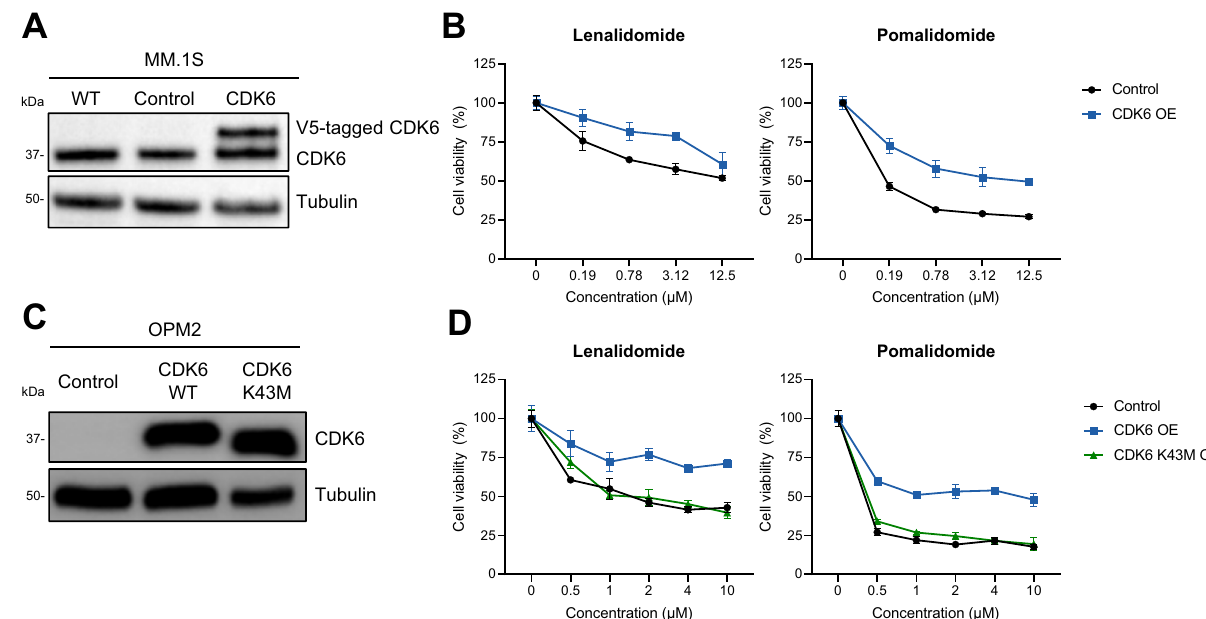
Fig. 2 High expression levels of CDK6 confers augmented IMiD-resistance. A Overexpression of CDK6 in MM.1S cells using lentiviral transduction con fi rmed through western blot analysis. B Cell viability of CDK6-overexpressing MM.1S cells upon 96 h treatment with lenalidomide and pomalidomide at indicated concentrations. ( N = 3 biologically independent replicates). C Overexpression of CDK6 in OPM2 cells using retroviral transduction con fi rmed through western blot analysis. D Cell viability of CDK6 WT or K43M-overexpressing OPM2 cells upon 96 h treatment with lenalidomide and pomalidomide at indicated concentrations. ( N = 3 biologically independent replicates) Control denotes empty vector. Cell viability is normalized to respective DMSO conditions. Data represent the mean ± SD of biological triplicates. Source data are provided as a Source Data fi 123 or the VHL-recruiting PROTAC CST528 that degrades both CDK4 and CDK6. Consistent with the results for the kinase reduced multiple myeloma cell growth in a subset of cell lines.